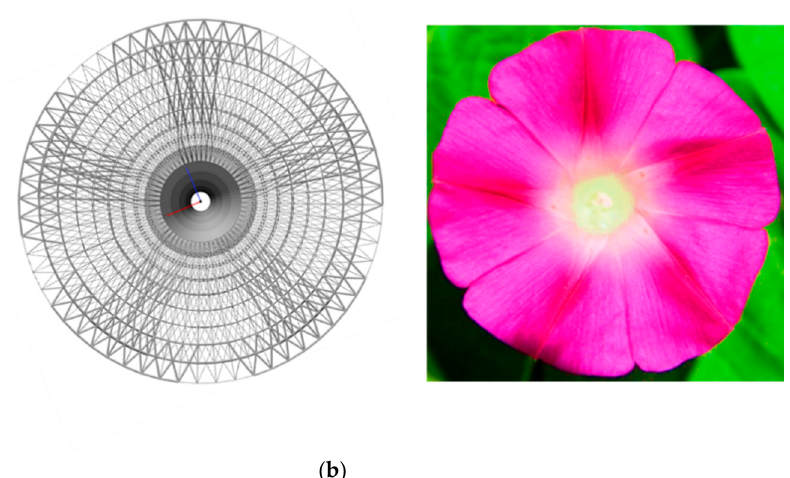
Figure 21. Final optimized structure of the horn structure: ( a ) three-dimensional stereogram; and ( b ) vertical view.